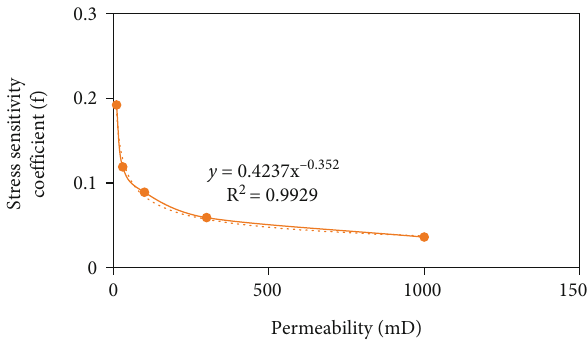
Figure 4: Distribution of stress sensitivity coe ffi cient under di ff erent